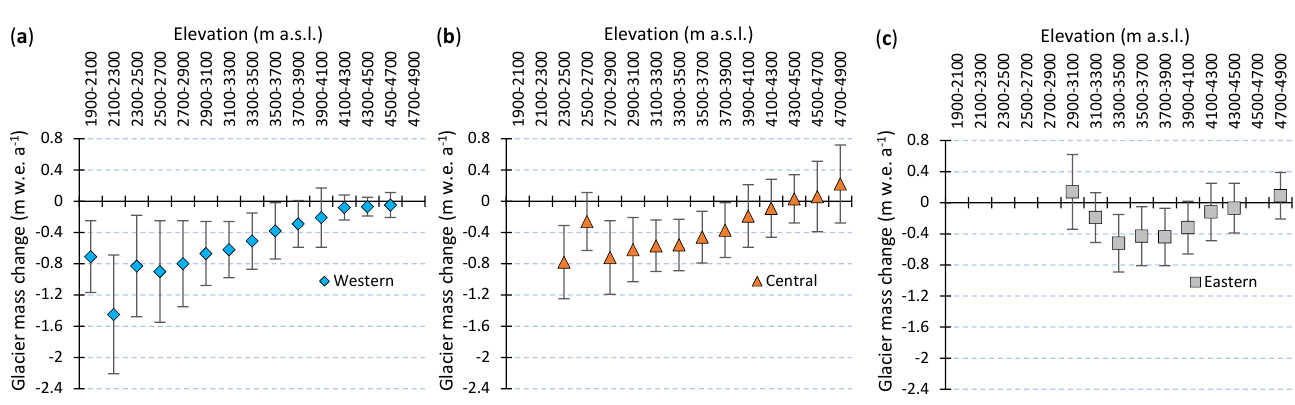
Figure 10. Change in mean annual geodetic mass balance (m w.e. a −1 ) as a function of mean elevation (m a.s.l.) in western ( a ), central ( b ), and eastern ( c ) Greater Caucasus between 2000 and 2019. Elevation bands in 200 m. Vertical stems show an uncertainty estimation of the mean values.